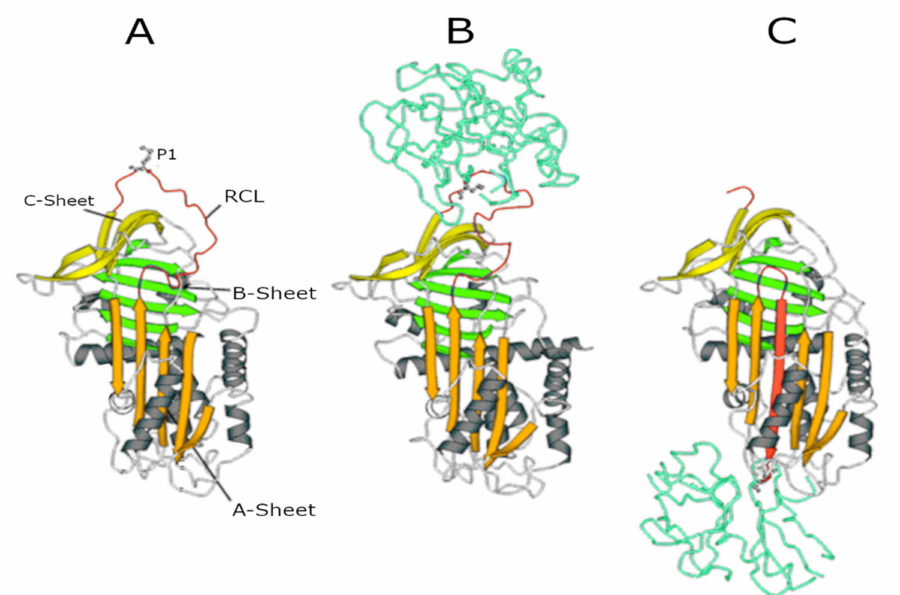
Figure 1. Serpin structures. ( A ) Native alpha1-antitrypsin (AAT); ( B ) Michaelis complex between AAT and trypsin; and ( C ) covalent complex between AAT and trypsin. In all structures, the A-sheet is in orange, the B-sheet is in green, and the C-sheet is in yellow. The reactive centre loop (RCL) in the upper pole of the molecule shows the P1 residue (Met358) recognised by